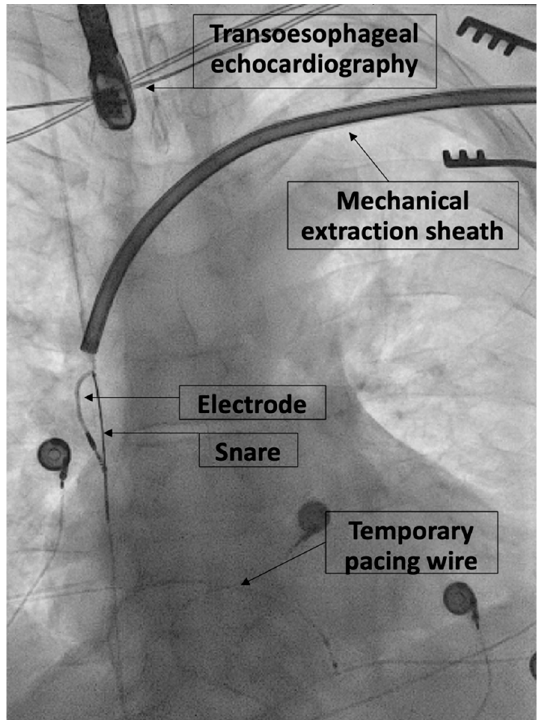
Figure 1. X-ray during lead extraction with combined superior and femoral approach.